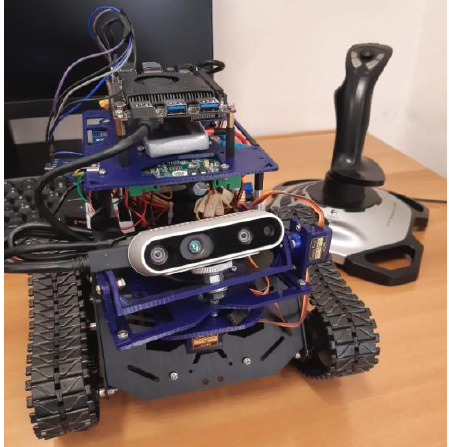
Figure 3. Aerospace autonomous robots with onboard intelligent algorithms (STREAMS) Lab Robot (https://sites.google.com/view/streamrobotics-polito/home, accessed on 3 October